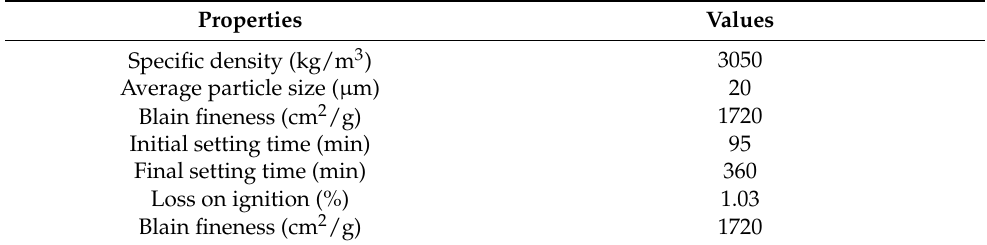
Table 4. Physical properties of cement.